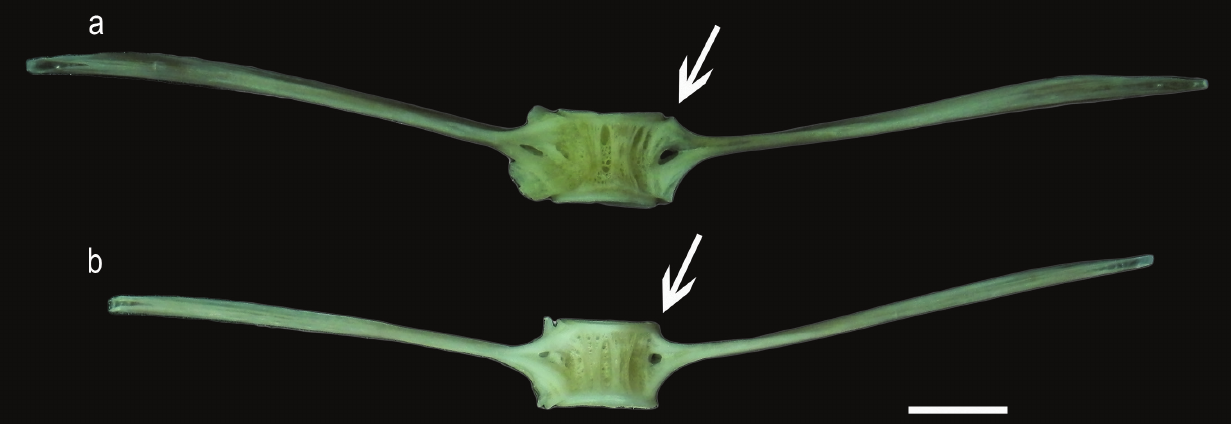
Fig. 4. Fourth caudal vertebrae of Paralichthys : a. P. orbignyanus , b. P. patagonicus . Arrow indicates haemal zygapophyses. Scale bar indicates 9